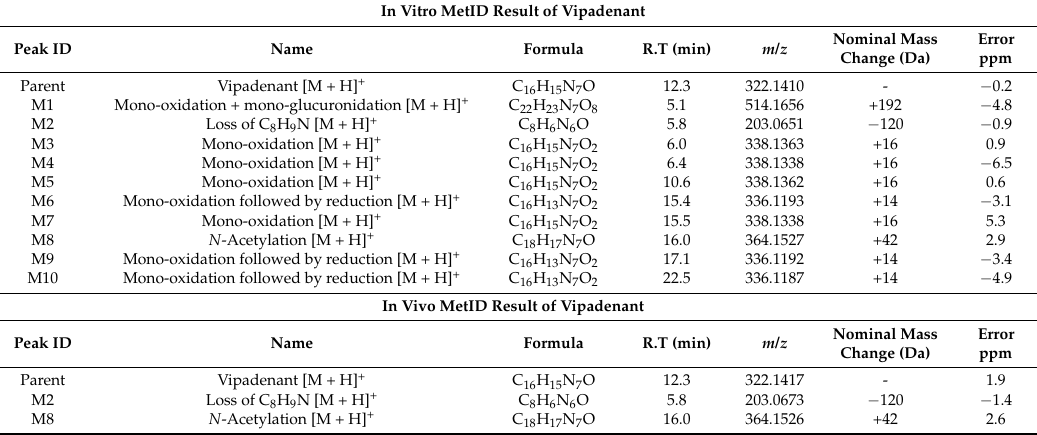
Table 6. Characteristics of the in vitro/vivo vipadenant MetID results by LC-QTOF-MS/MS assay. In Vitro MetID Result of